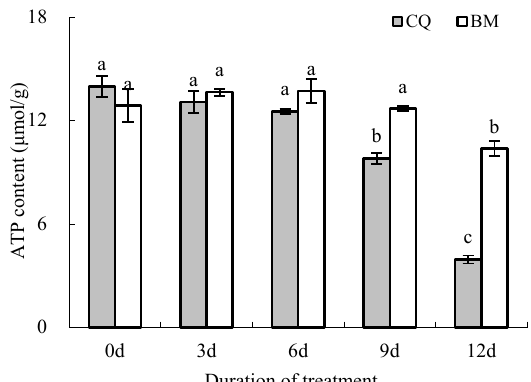
Figure 4. Determination of the ATP content in the mitochondria of cucumber roots at 0, 3, 6, 9, and 12 days after Ca(NO 3 ) 2 treatment. Values are the means of three independent experiments. Bars marked with dissimilar letters are significantly different according to Duncan’s multiple range tests ( p < 0.05).